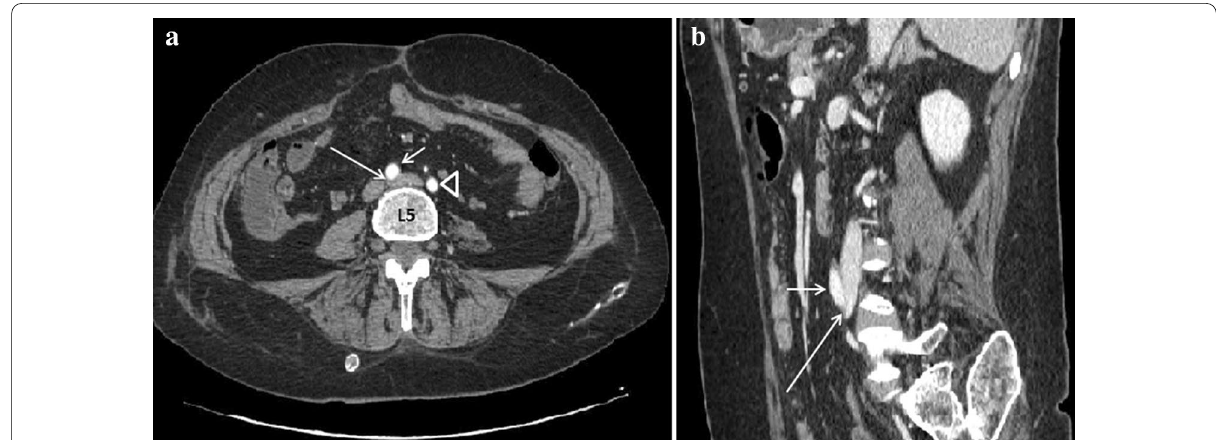
Fig. 13 Abdomen MDCT examination. a The axial plane reconstruction shows a stenosis of the left common iliac vein (long arrow) by the right common iliac artery (short arrow) against the vertebral column. Fifth lumbar vertebra (L5). Left common iliac artery (head arrow). b The sagittal plane reconstruction shows the point where the right common iliac artery (short arrow) compresses the left common iliac vein (long arrow) against the vertebral column